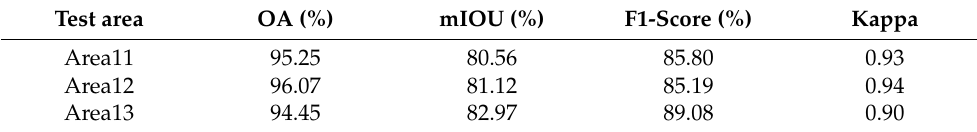
Table 1. The calculated evaluation metrics for the test areas.